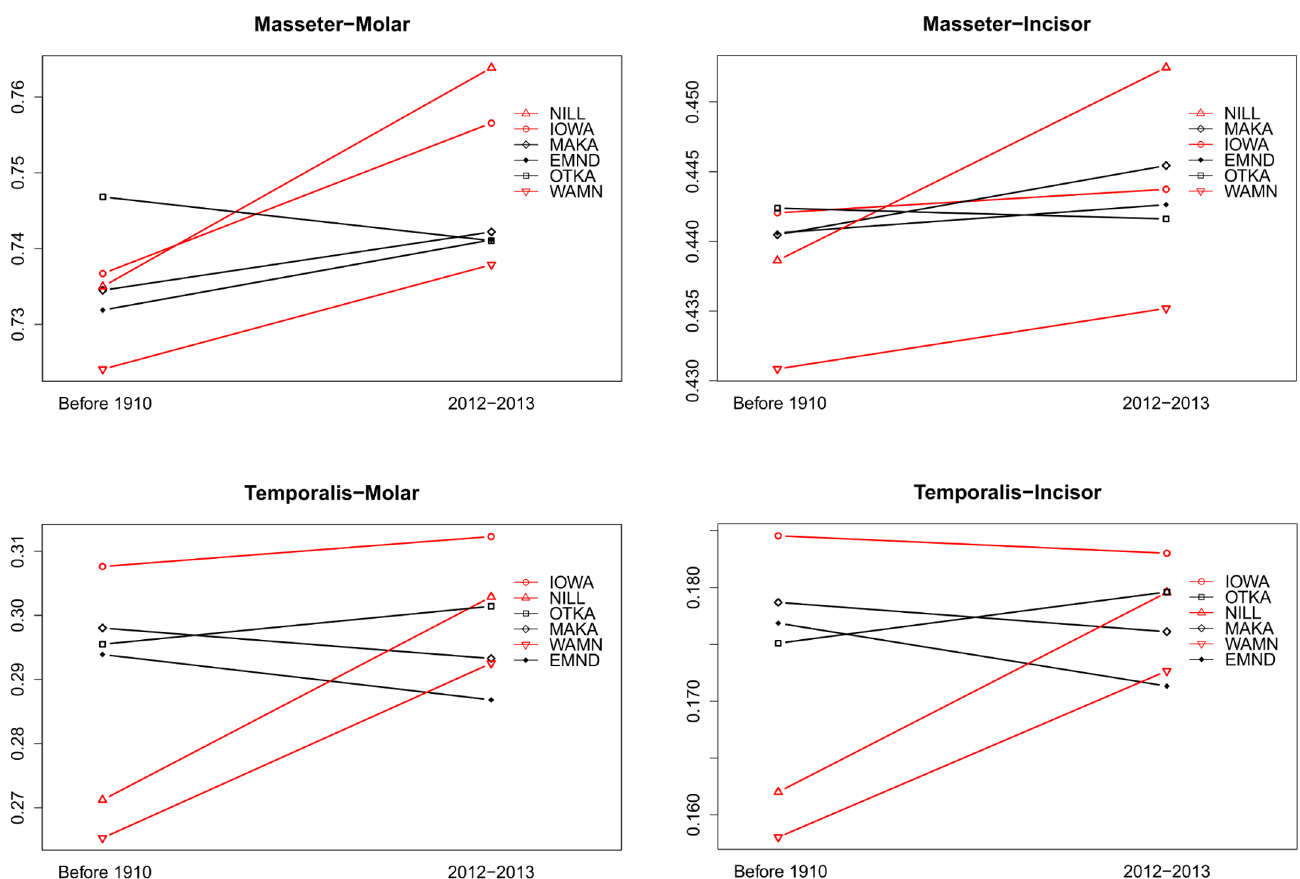
Fig 7. Biomechanical ratios of jaw morphology. Biomechanical ratios represent a measure of bite strength, and thus larger values represent greater bite strength at either the incisor or molars. Masseter length is the length from the condyle tip (jaw leverage) to the point of maximum curvature of the ventral side of the mandible. Temporalis length is the length from the condyle tip to the tip of the coronoid process. Incisor length in our study was the length from the condyle tip to the dorsal insertion point of the incisor (see methods for description of why the incisor was not included in the study). Molar length is the length between the condyle tip and the anterior insertion point of the first molar. These lengths are slight modifications from Anderson et al. [39]. Values in all graphs are ratios of lengths and are thus unitless. Site abbreviations and sample sizes are as in Table 1. Sites with greater than or equal to 75% corn-soybean cover in the landscape are depicted in red, while sites with less than or equal to 33% corn-soybean cover are depicted in black.